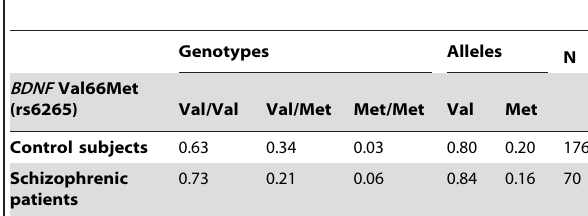
Table 4. Allele and genotype frequencies of BDNF polymorphism rs6265 (Val66Met) in control subjects and schizophrenic